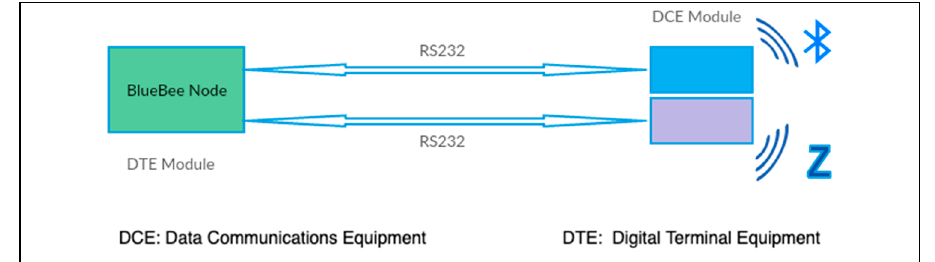
Figure 10. BlueBee: Bluetooth-Zigbee gateway [19]. Reproduced with permission from Garcia et al., IEEE 2011.